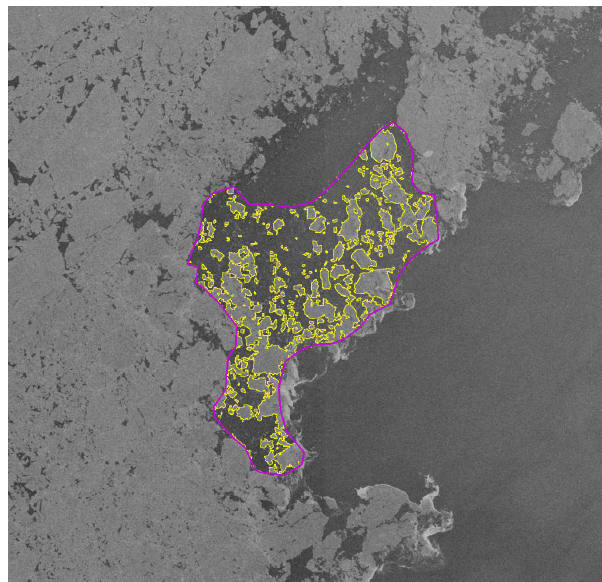
Figure 3. An example of a polygon in a RADARSAT-2 image (de- lineated area shown in magenta). The yellow outline is the cal- culated demarcation separating pixels tagged as ice from pixels tagged as water by the MAGIC algorithm. RADARSAT-2 Data and Products © MDA Geospatial Services Inc. (2012) – All Rights Re- served. RADARSAT is an official trademark of the Canadian Space